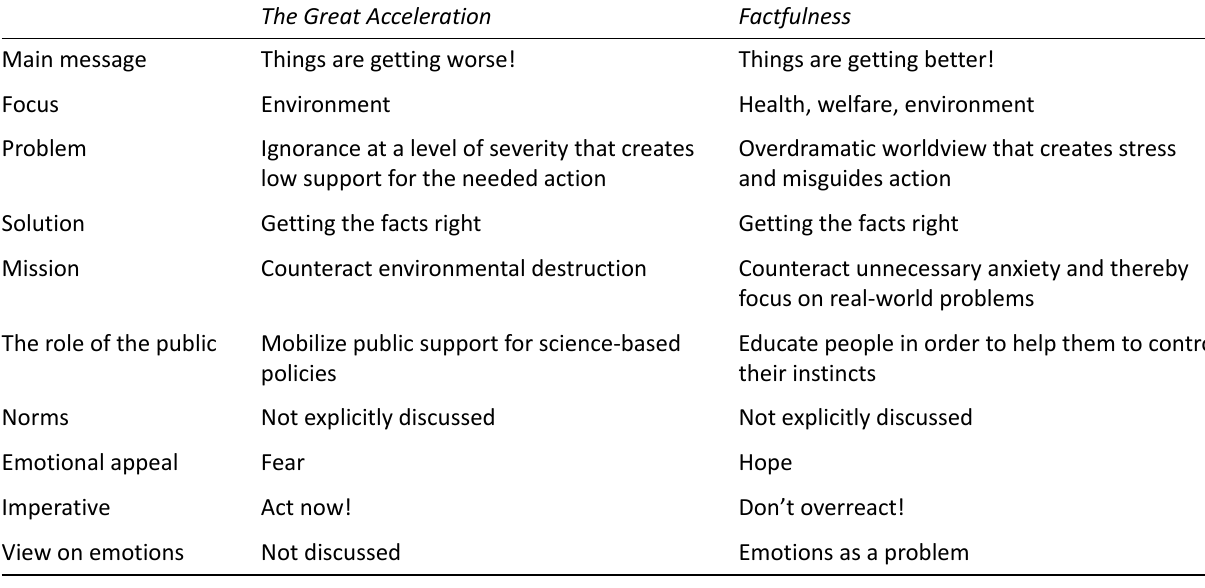
Table 1. Comparison of the storylines of The Great Acceleration and Factfulness